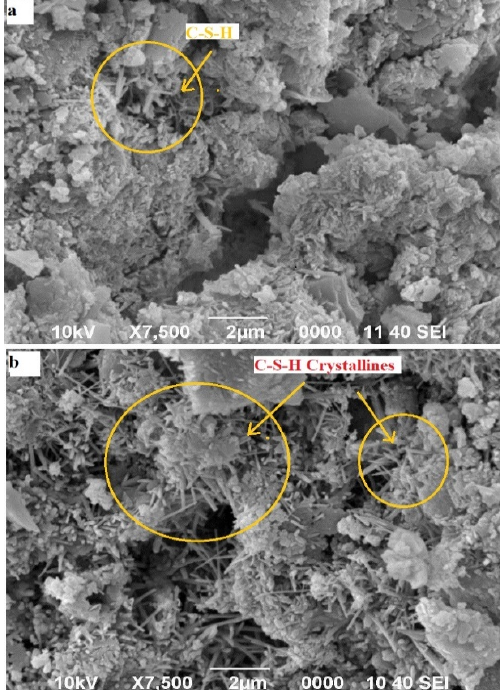
Figure 11. SEM images indicating the hydration products at the ages of ( a ) 28 and ( b ) 90 days.